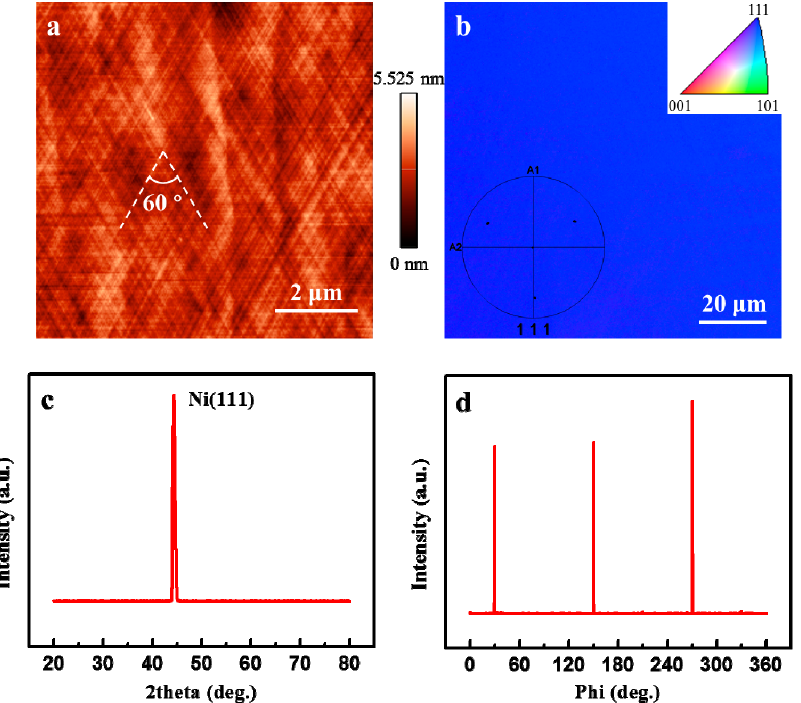
Figure 1. Typical characterization results of the single-crystal Ni (111) film. ( a ) AFM image of the Ni (111) film annealed in the quartz tube. ( b ) Out-of-plane EBSD mapping of the Ni (111) thin film. The inset shows the pole figure of the same region. ( c ) XRD θ -2 θ scan and ( d ) HRXRD azimuthal off-axis φ scan of the Ni (111) film.